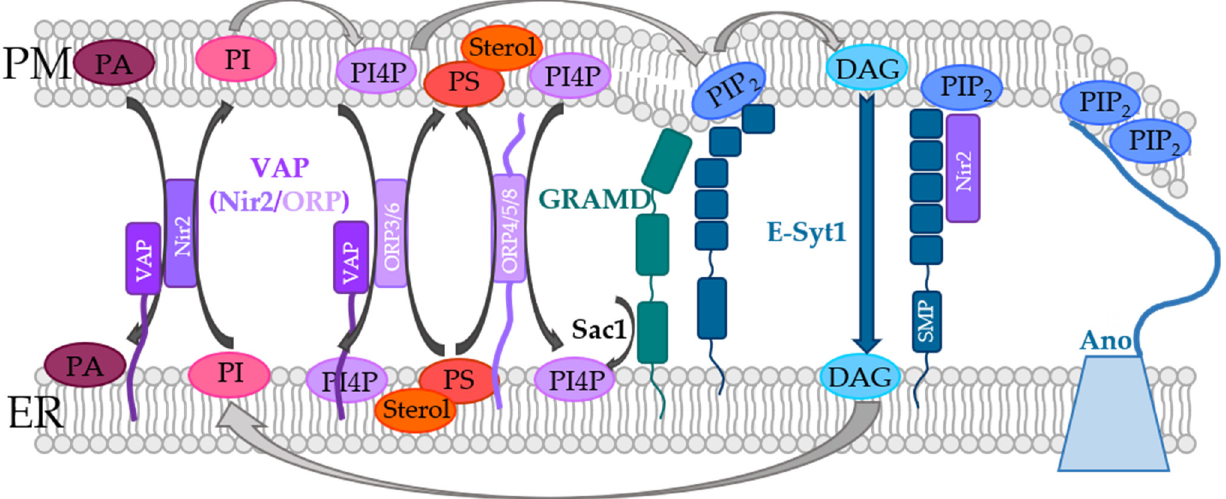
Figure 3. ER-PM spanning proteins involved in the modulation of the CRAC channel complex. In addition to the PI cycle, phospholipids can also be transported by ER-PM spanning protein, allowing non-vesicular transport. The localization of ER-PM spanning proteins depends mainly on the lipid composition in the PM, in particular the PIP 2 levels. E-Syt proteins are anchored in the ER membrane and are either Ca 2+ -dependently (E-Syt1) or -independently (E-Syt2, E-Syt3) bound to PIP 2 in the PM. E-Syt proteins can transport DAG from the PM to the ER membrane. Furthermore, E-Syt1 co-localizes with Nir2 to modulate PIP 2 levels in the PM. VAP proteins exchange PI and PA between the ER and PM. Moreover, VAP proteins associate with Nir2 or ORP3/6 to span from the ER to the PM.